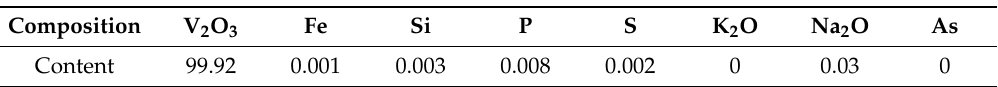
Table 5. Chemical composition of V 2 O 3 products obtained at 523 K for 2 h with H 2 partial pressure of 4 MPa and reaction time of 2 h wt %.